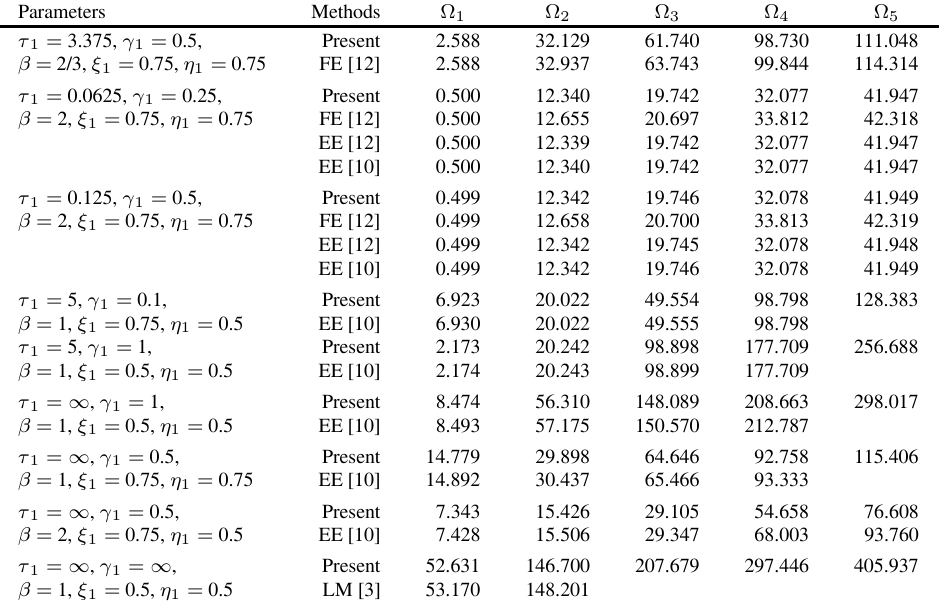
Table 3 Comparison of the fi rst fi ve coupled eigenfrequencies with published data (SSSS rectangular plates with one